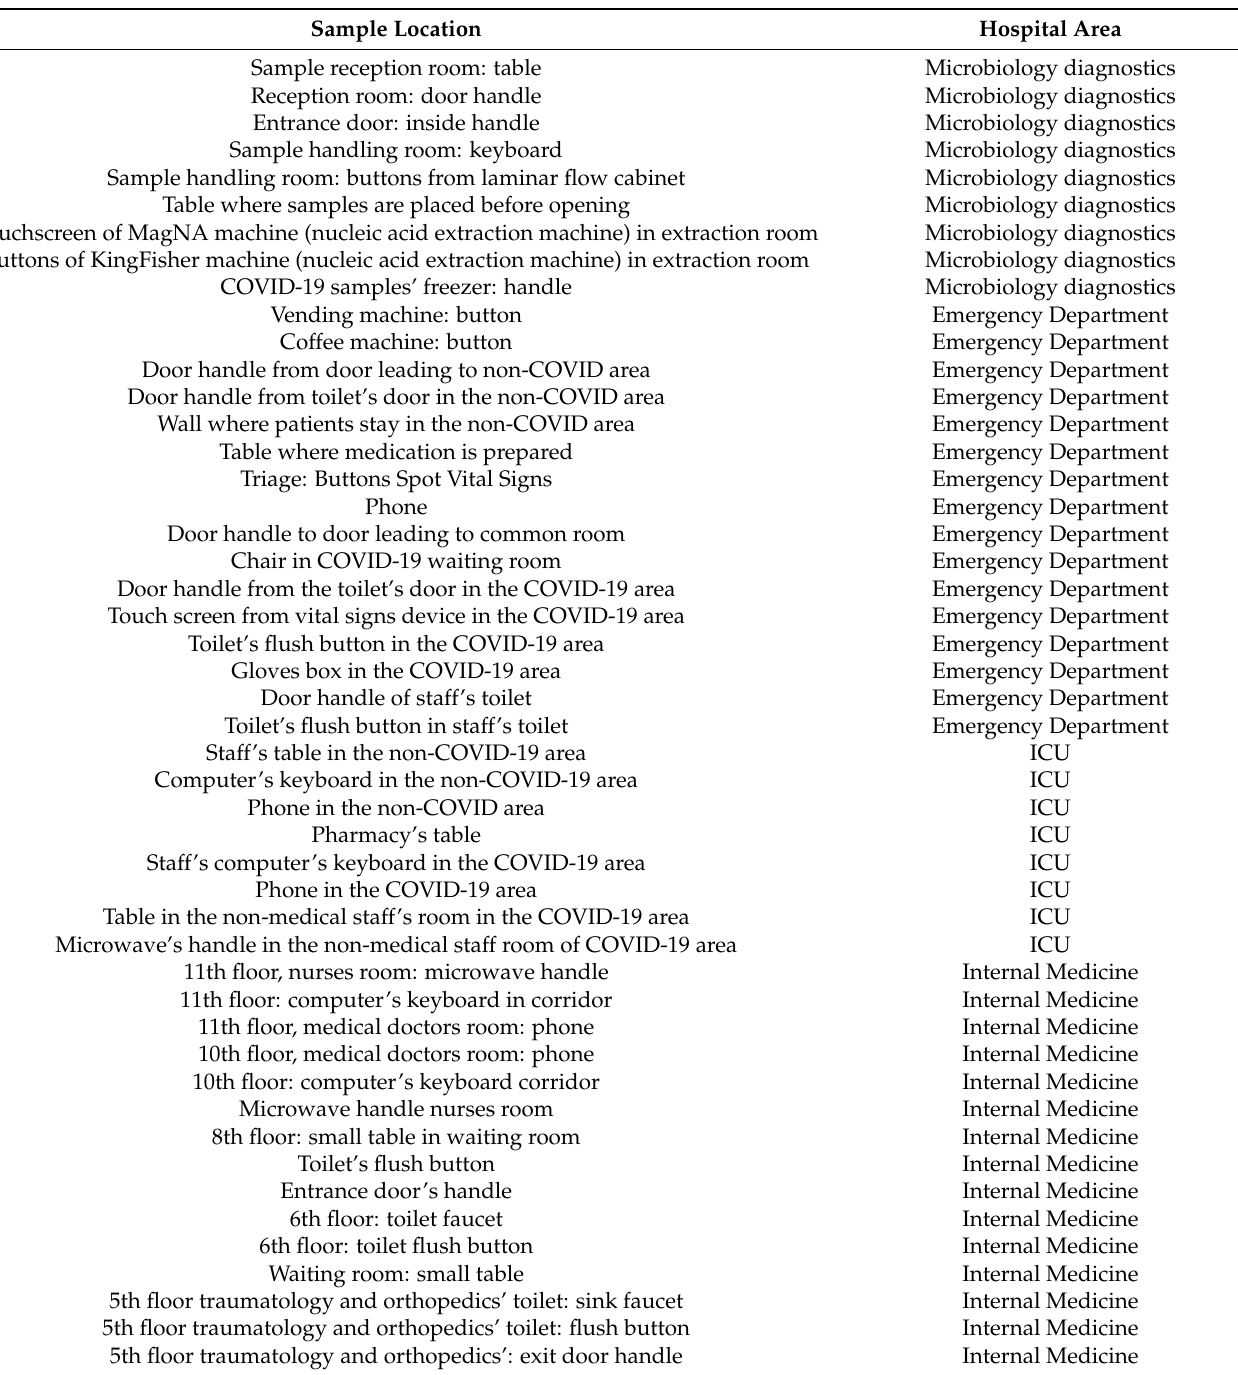
Table 2. Details from surface samples